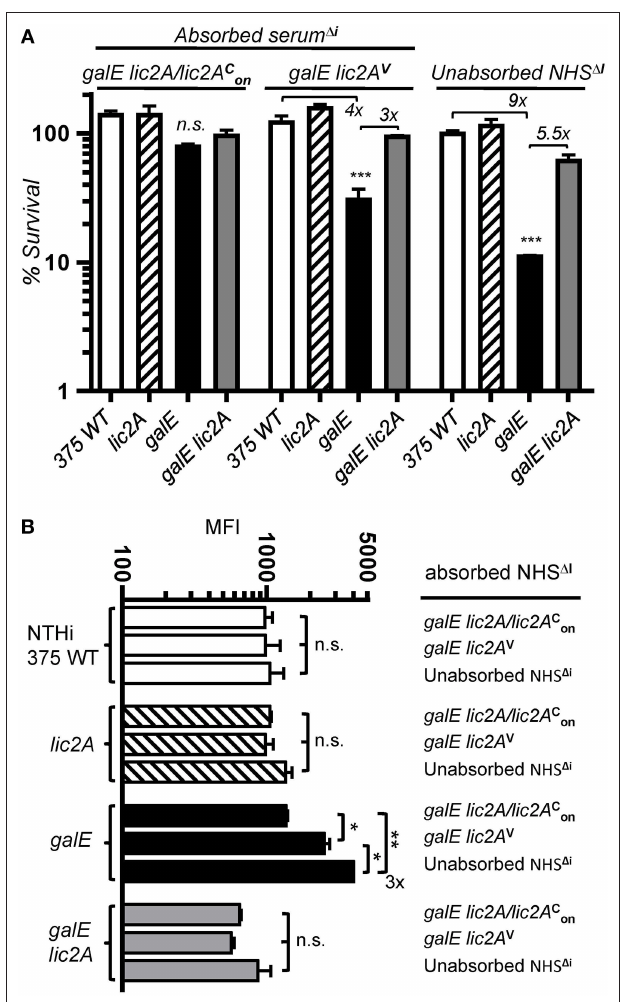
FIGURE 11 | Absorption experiments indicating a lic2A dependent epitope in the galE mutant that confers increased killing by serum and IgM binding. (A) Serum pre-absorbed of the antibody that targets the lic2A dependent epitope in the galE mutant promotes decreased killing of the galE mutant. Viability of the indicated strains grown on MIc SA following incubation with 10% NHS 1 i pre-absorbed with strains RdgalElic2A/lic2A C on (GalE − , Lic2A + ) or RdgalElic2A V (GalE − , Lic2A − ) vs. control unabsorbed NHS 1 i , followed by incubation with 3% HC at 37 ◦ C for 30min. Percent survival is the ratio of CFU recovered from absorbed or unabsorbed serum treated samples after HC incubation to CFU recovered from non-serum treated (buffer only) samples after HC incubation. Lower limit of detection is approximately 0.25% survival. Differences between the galE mutant vs. the other three strains within a treatment group were statistically significant by ANOVA, *** p < 0.001. (B) Serum pre-absorbed of the antibody targeting the lic2A dependent epitope in the galE mutant contains decreased IgM specific to the galE mutant. Strains grown on MIc SA were incubated with 10% NHS 1 I pre-absorbed with RdgalElic2A/lic2A C on or RdgalElic2A V or control unabsorbed NHS 1 I at 37 ◦ C for 30min followed by detection via flow cytometry with anti-human IgM conjugated to FITC. IgM binding from the mean of replicate samples. Log-transformed survival ratios and MFI values were evaluated by one-way ANOVA with Bonferroni’s multiple comparison test (* p < 0.05; ** p < 0.01; n.s., not statistically